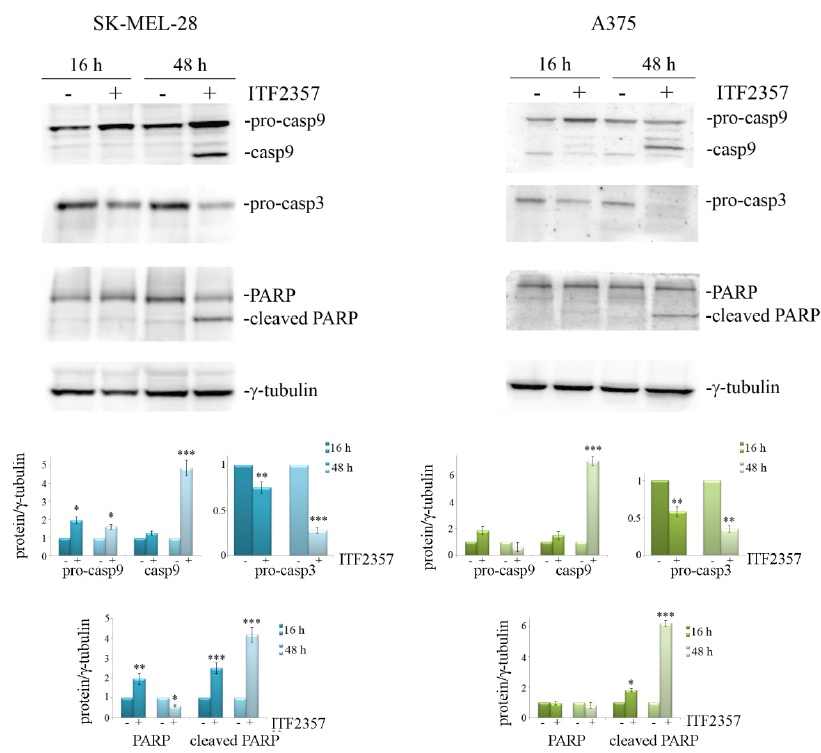
Figure 9. The effects of ITF2357 on apoptotic markers. SK-MEL-28 and A375 cells were treated for 16 and 48 h with 5 µM and 2 µM ITF2357, respectively. Western blot analysis of apoptotic proteins was performed as reported in Materials and Methods. Representative blots of three independent experiments and densitometric analysis are shown. * p < 0.05, ** p < 0.01, *** p < 0.001.